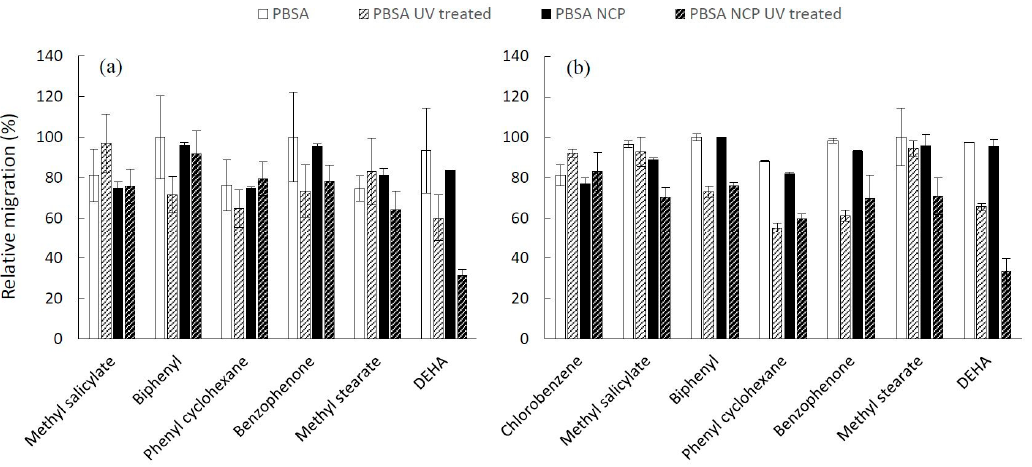
Figure 5. Comparison of the relative migrations of additives from PBSA, PBSA NCP and the corresponding aged materials to 95% ethanol ( a ) and isooctane ( b ) after 10 days of contact.